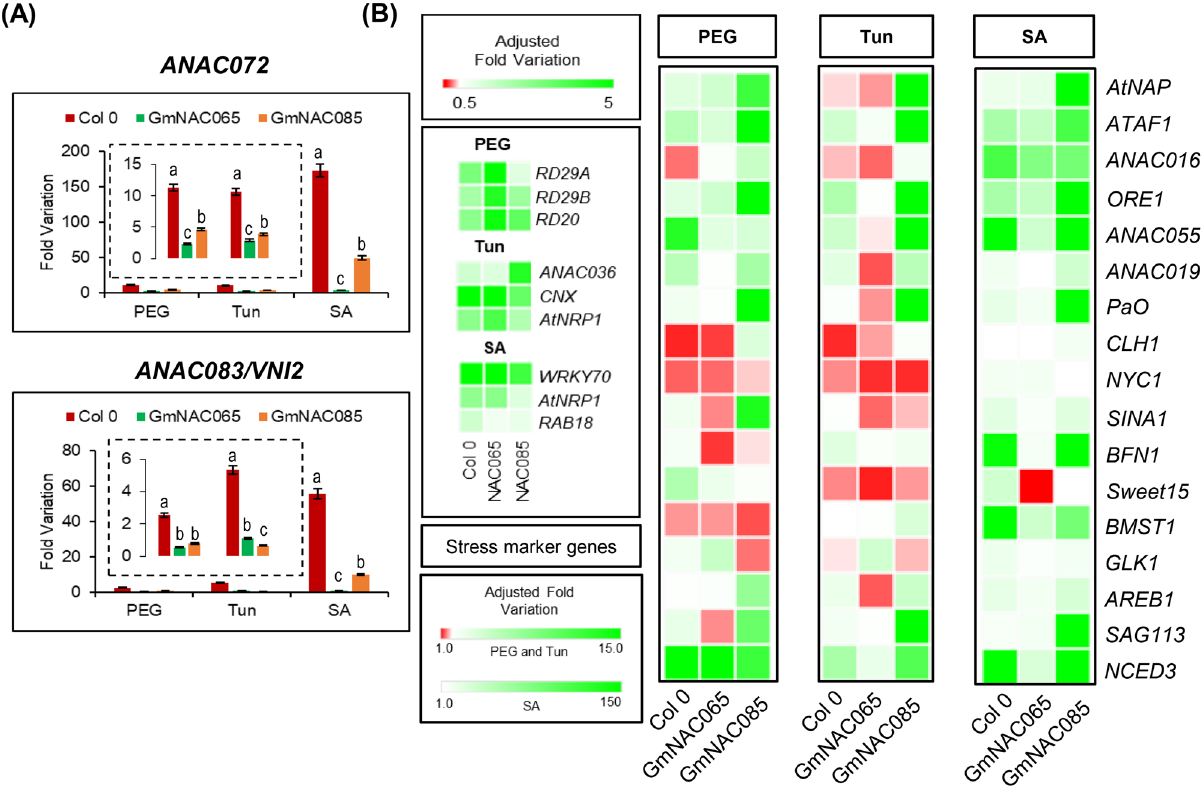
Figure 9. AtSAGs expression in GmNAC065-OX and GmNAC085-OX plants under different stresses. ( A ) Expression levels of ANAC083/VNI2 and ANAC072 , a negative and positive regulator of senescence in Arabidopsis, and the putative orthologous of GmNAC065 and GmNAC085 , respectively. ( B ) Expression levels of stress marker genes and AtSAGs in transgenic lines ectopically expressing GmNAC065 and GmNAC085 . ACT2 was used as the endogenous control gene. Relative gene expression was quantified using the comparative 2 −ΔΔCt method. Upper bars indicate standard error (95% of confidence), and the different letters indicate significant differences among the lines by the Tukey’s test (p < 0.05, n =